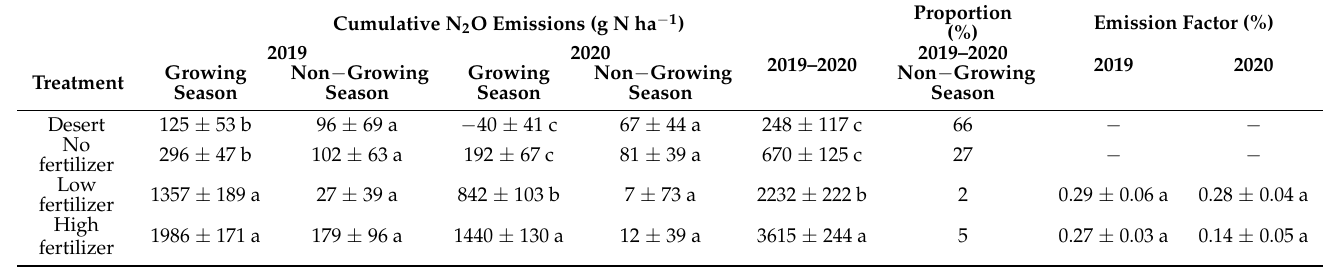
Table 3. Cumulative N 2 O emissions, the proportion of N 2 O emissions from non − growing season to total emission, and applied N scaled emission factor as affected by fertilizer treatments. Values are the means ± 1 standard error, n = 4 for